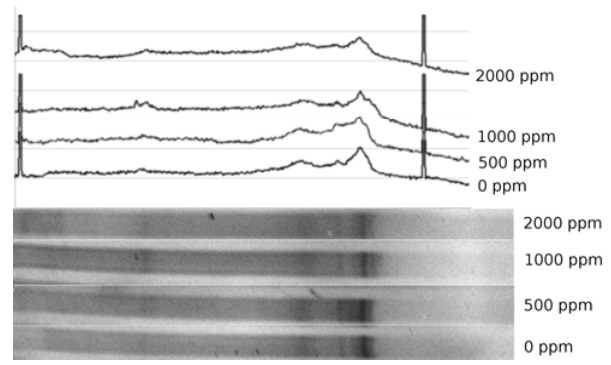
Figure 4: DGGE profile of nirK marker in high-Pb experiment. Bottom part, gel image; top part, digitized density profile of the gel. Spikes at extreme left and right of the graph with no corresponding bands are reference marks for gel alignment